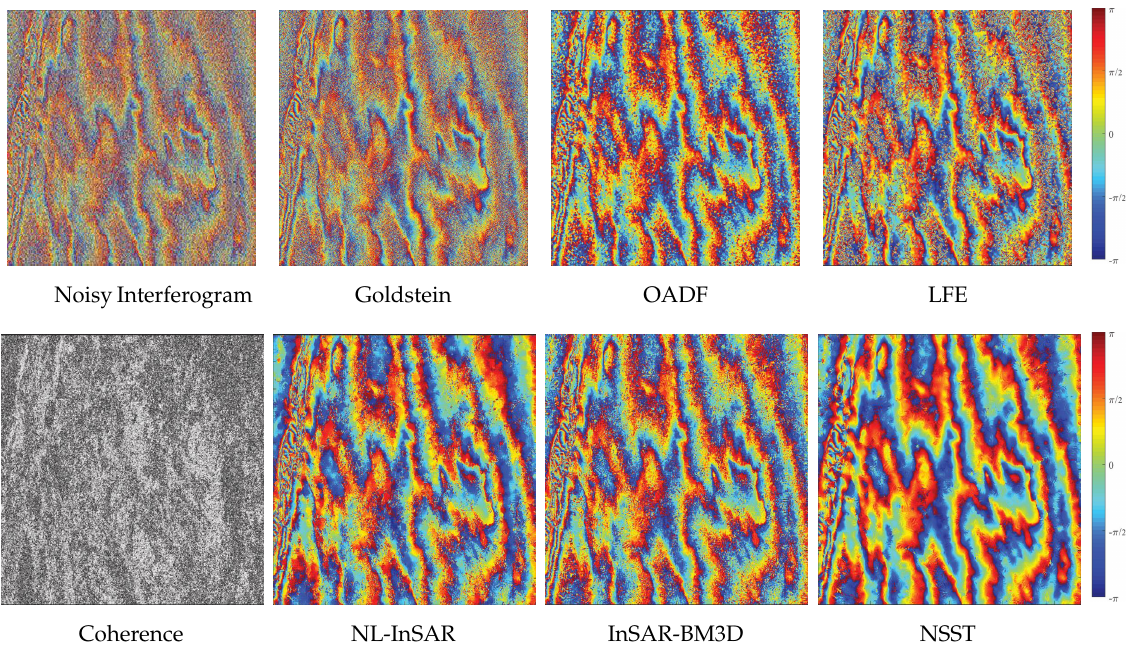
Figure 15. The filtered results of the low-coherence reagion (the upper right corner of real interferogram with the longest baseline (row: 1:1000, column: